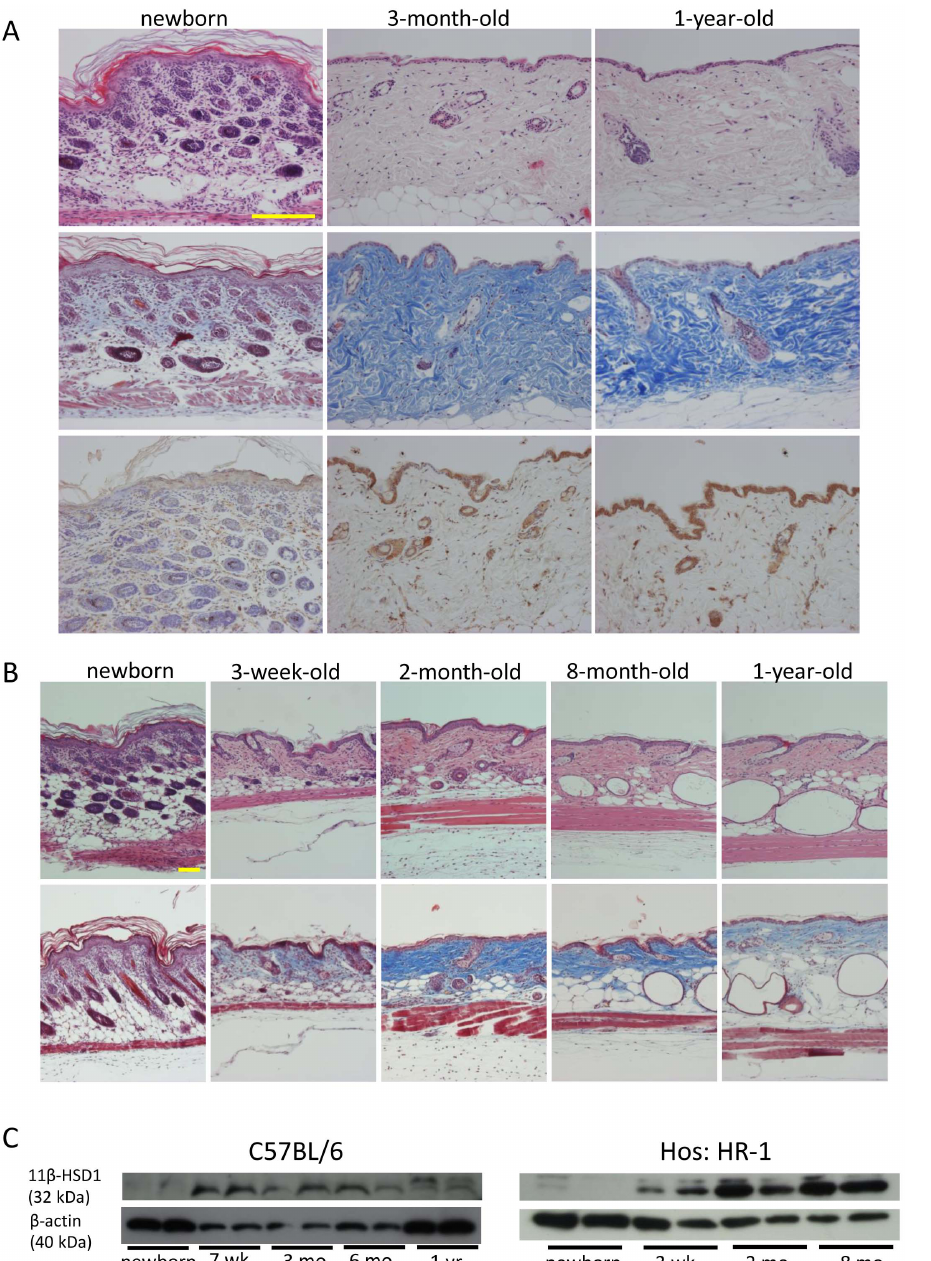
Figure 1. Histological analysis and changes in 11 b -HSD1 expression in mouse skin during aging in C57BL/6 and Hos: HR-1 mice. (A) H&E staining (upper panel), Masson’s trichrome staining (middle panel), and 11 b -HSD1 staining (lower panel) of newborn, 3-month-old, and 1-year- old C57BL/6 mouse skin. Bar =100 m m. (B) H&E staining (upper panel) and Masson’s trichrome staining (lower panel) of newborn, 3-week-old, 2- month-old, 8-month-old, and 1-year-old Hos: HR-1 mouse skin. Bar =100 m m. (C) Western blot analysis of 11 b -HSD1 expression in mouse skin harvested from newborn, 7-weeks-old, 3-month-old, 6-month-old and 1-year-old mouse skin (C57BL/6), and newborn, 3-week-old, 2-month-old, and 8-month-old mouse skin (Hos: